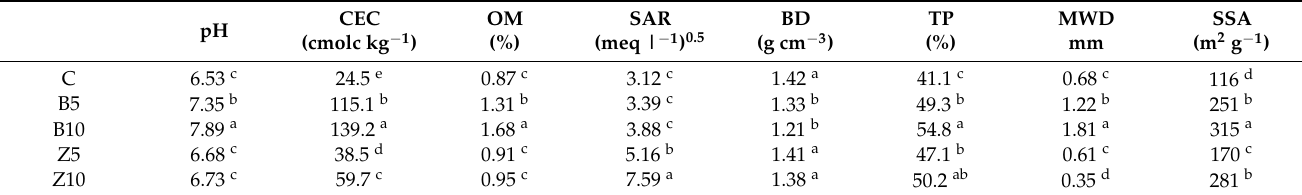
Table 2. Soil characteristics under biochar and zeolite